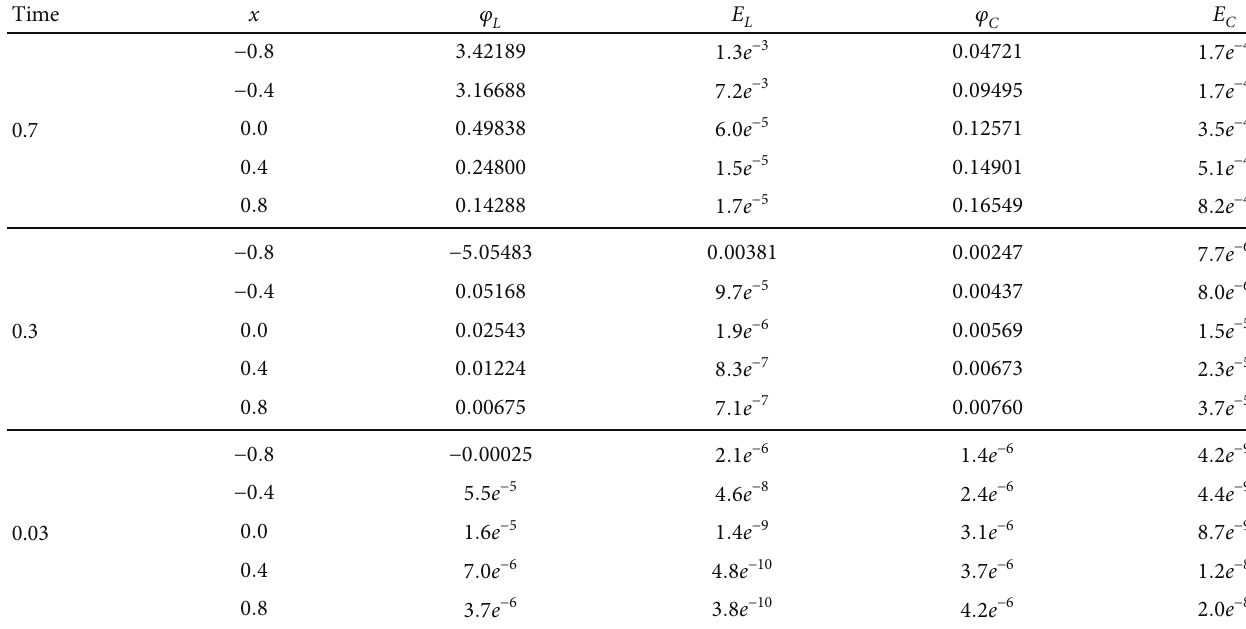
Table 3: V ð t , τ Þ = t τ , G ð t , τ Þ = t 2 τ 2 , L ð x Þ = ð 1 + x Þ 3 , N = 17, A ð t Þ = ln ð 1 : 3 + t Þ .